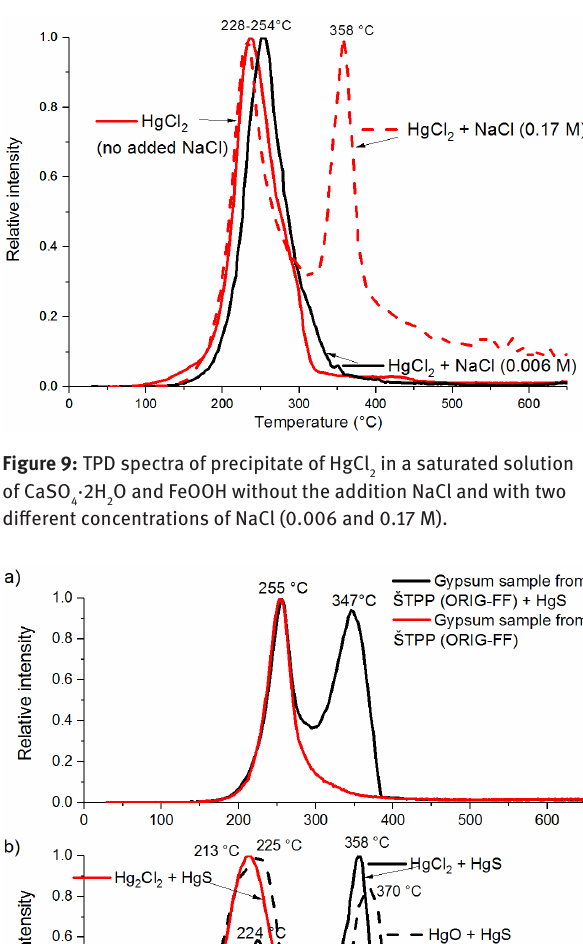
Figure 10: TPD spectra of a) ORIG-FF with and without HgS